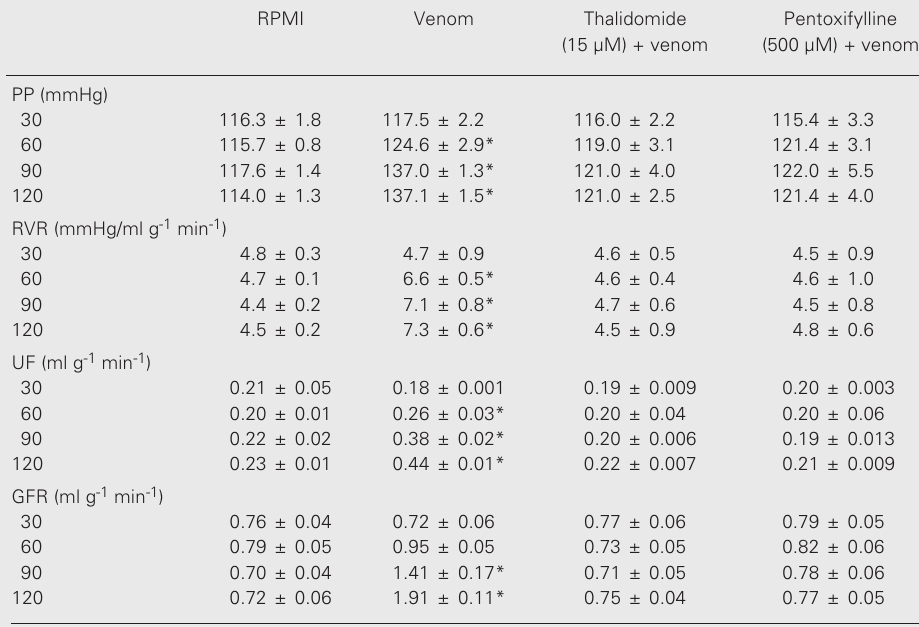
Table 1. Thalidomide and pentoxifylline inhibit the renal effects of the supernatant of macrophages stimulat- ed with Crotalus durissus cascavella venom. RPMI Venom